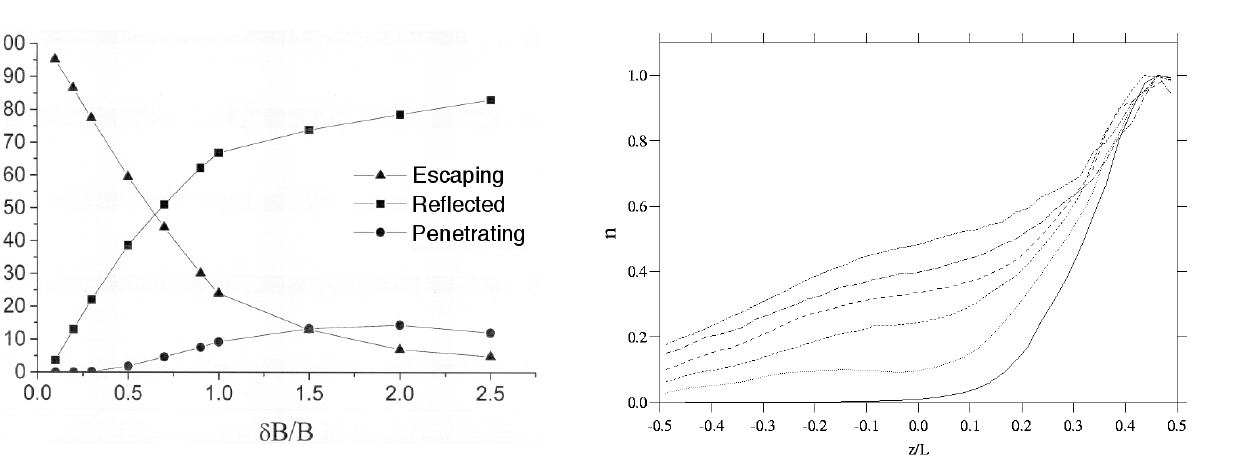
Fig. 10. The cross layer profile of normalized ion density for dif- ferent δB/B 0 . The lowest solid curve corresponds to the small- est δB/B 0 = 0 . 1, the dotted curve to 0.2, the short-dashed one to 0.3, the long-dashed one to 0.5, the dot-dashed to 0.7 and the upper curve to the largest δB/B 0 = 0 .